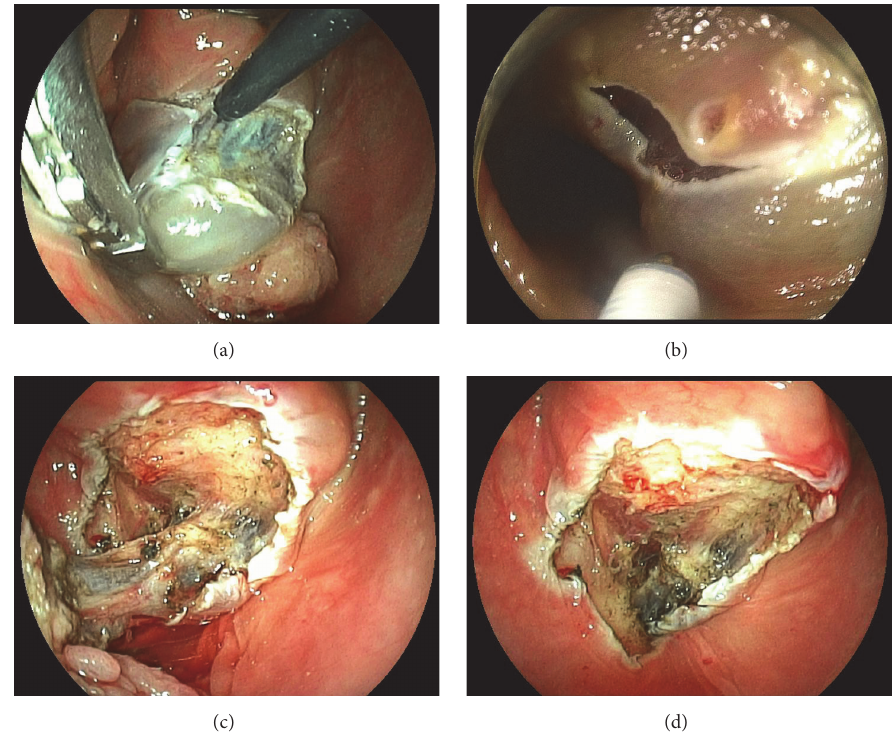
Figure 4: (a) After saline was injected into the subepithelial layer, the head and neck surgeon dissected the lesion using the orally inserted curved grasping forceps with one hand and the orally inserted curved electric needle knife with the other. (b) The esophageal portion was resected by ESD. (c) The pharyngeal portion was resected by ELPS. (d) After tumor removal, the tumor was resected en